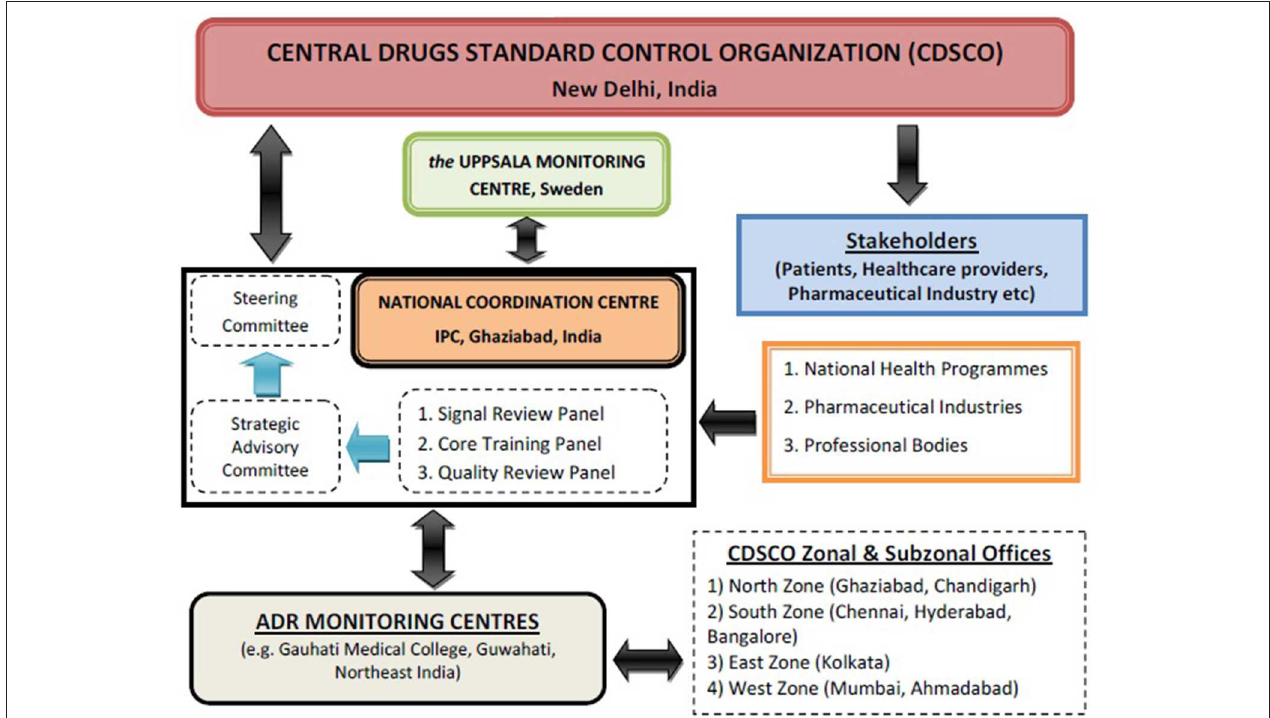
FIGURE 1 | Programme Communication & flow of ADR